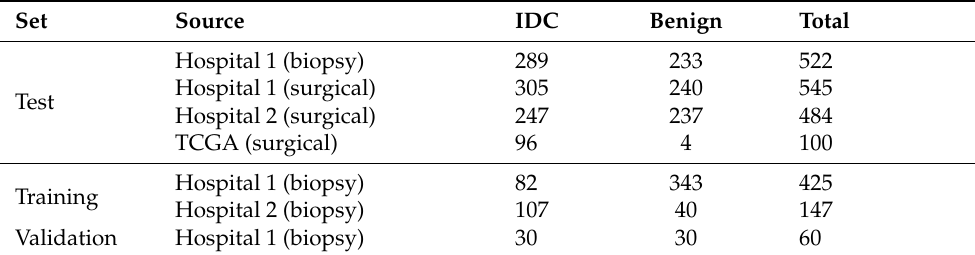
Table 1. Distribution of WSIs in the different